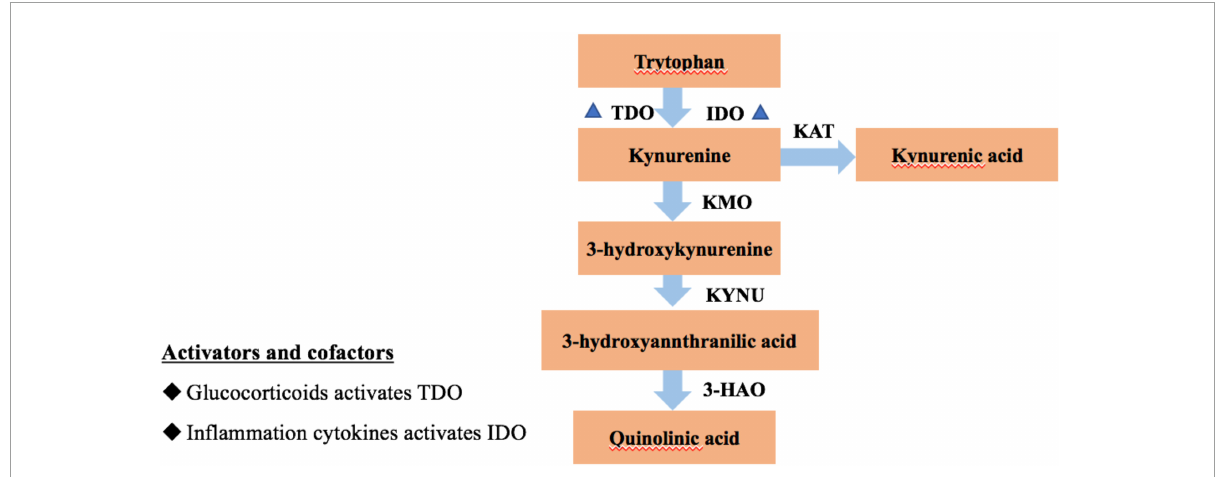
FIGURE1 Tryptophan metabolism along the kynurenine